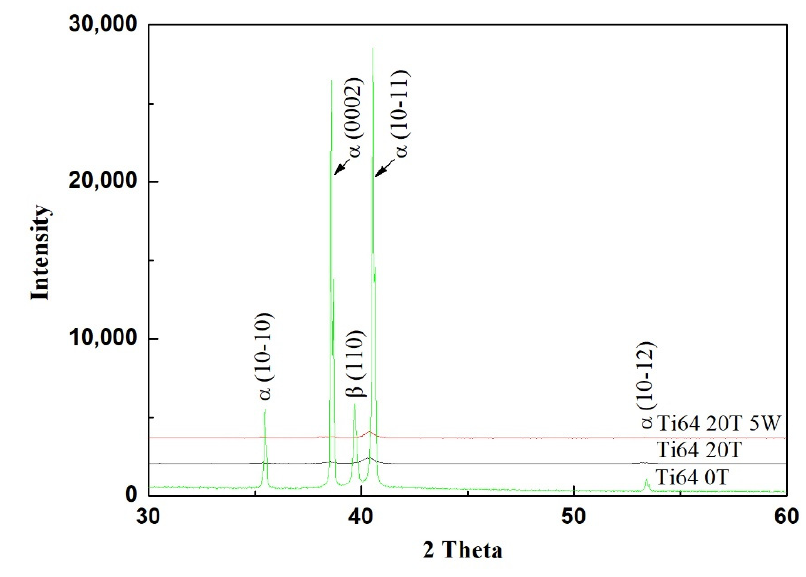
Figure 9. XRD spectra of the heat-treated but unstrained N0 sample, HPT-processed N20 sample and the surface-modified N20 sample of Ti64 at a laser power of 5 W.